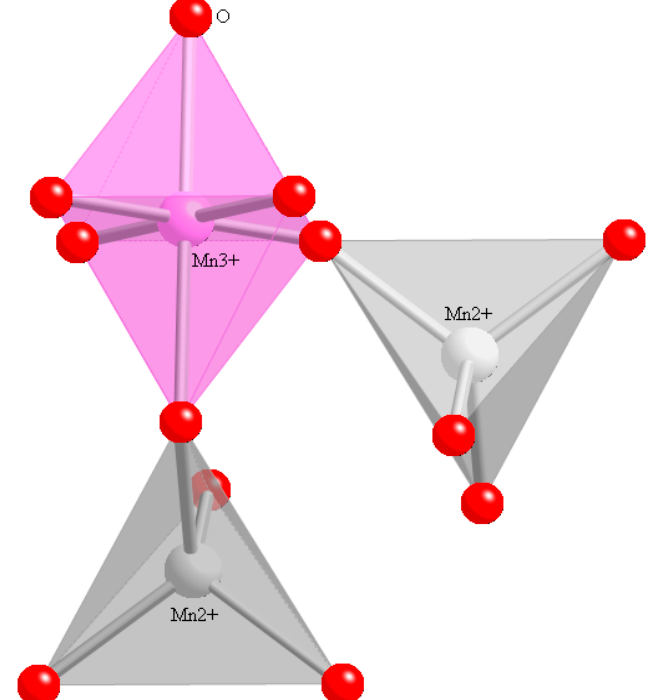
Figure 1. Part of the tetragonal hausmannite structure consisting of Mn 2 + O 4 tetrahedra (grey) and Mn 3 + O 6 octahedra (pink) that contains Jahn–Teller elongation of two apical O atoms that occur in the vertical direction that is parallel to [001]; the four shorter basal Mn 3 + –O bonds of the bypyramid are